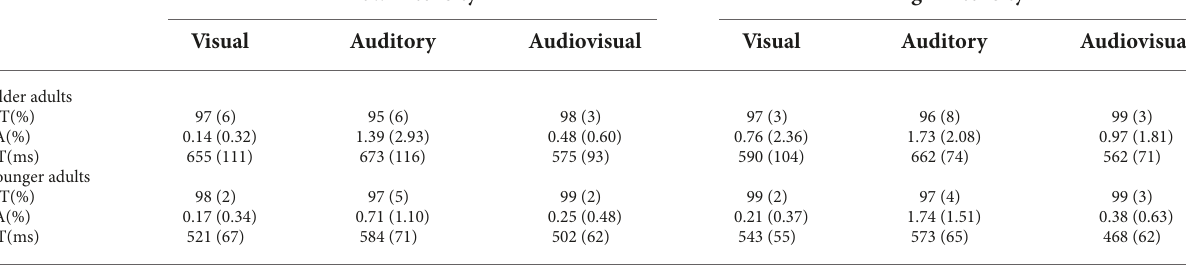
TABLE 1 Response times and hit rates for both the younger and older adults under the high-intensity and low-intensity